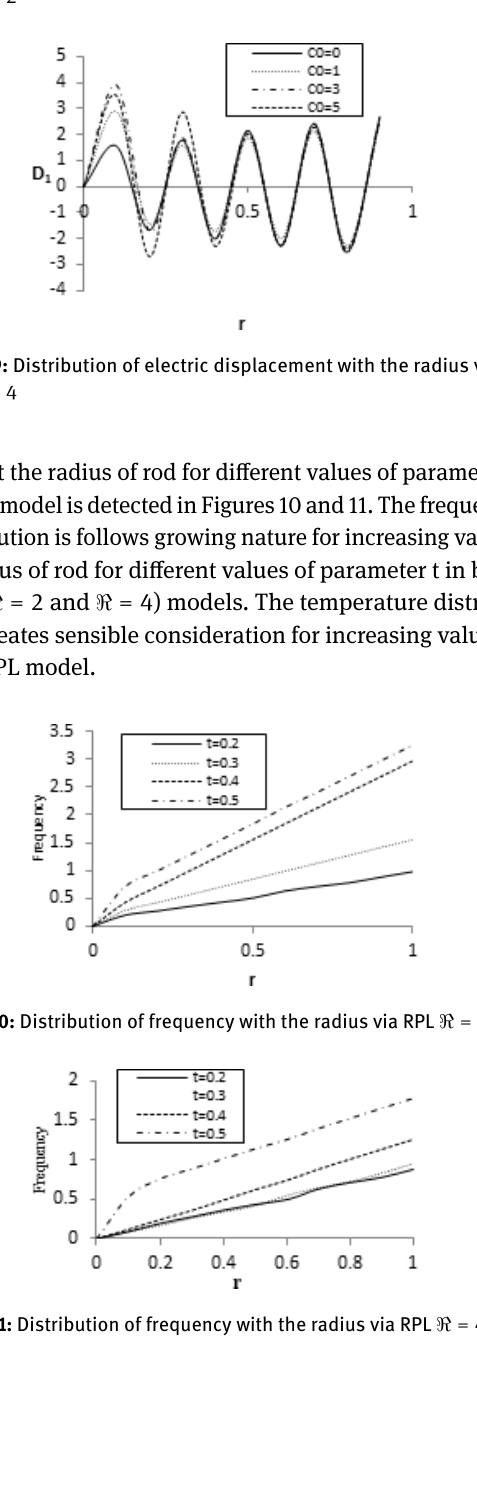
Figure 8: Distribution of electric displacement with the radius via RPL ℜ = 2